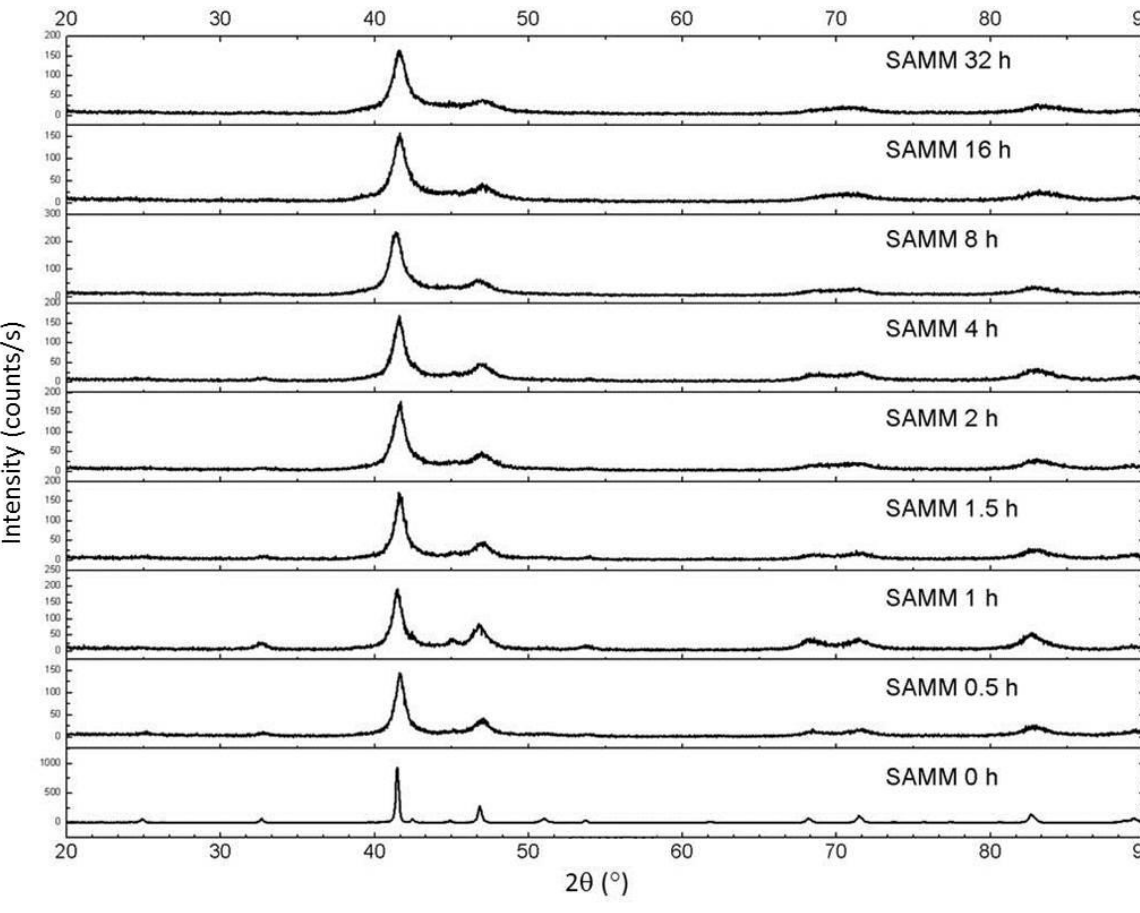
Figure 9. X-ray diffraction patterns of surfactant-assisted mechanical milling (SAMM) as a function of milling